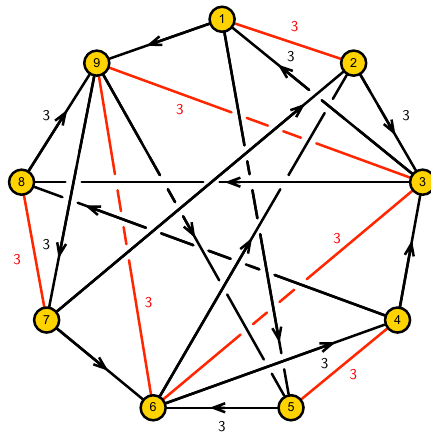
Figure 18 . Quiver for Y 3 , 3 ( CP 2 )